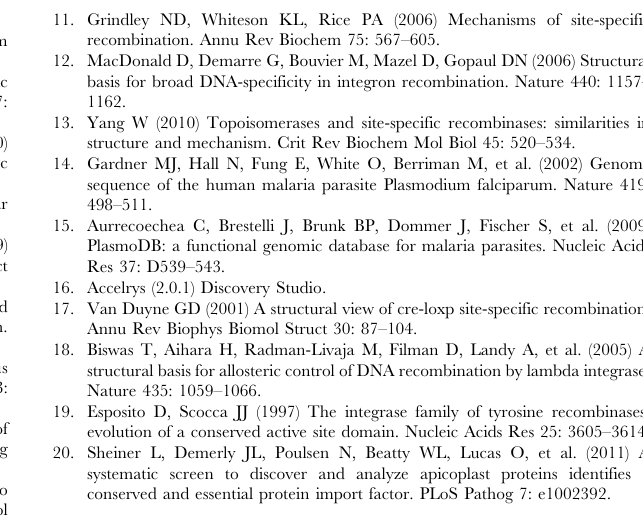
Figure S4 Analysis of DNA binding by Pf-Int. A ) Supershift assay confirms the presence of Pf-Int bound to the DNA. The binding of His 6 -Pf-Int-C192 to Selex8 DNA target was examined by supershift using either an antibody raised against the purified recombinant Pf-Int or a commercial anti-His 5 in combination with a His-tagged version of Pf-Int-C192 protein. 10 nM of Selex8 were mixed with 0.04 m M or 0.2 m M purified His 6 -Pf-Int-C192 (lanes 3, 5, 7 and 10) and (lanes 4, 6, 8 and 11) respectively. The DNA was pre-incubated with the corresponding amount of Pf-Int for 20 minutes at room temperature before adding the antibodies for an additional 20 minutes (lanes 5, 6, 10 and 11). For lanes 7 and 8, the purified Pf-Int was pre-incubated with the anti-Pf-Int for 20 minutes before addition of the DNA target. Addition of the Pf-Int antibody disrupts the formation of the DNA-Pf-Int complex (see lanes 5–8 in comparison with lanes 3–4: disappearance of shifted band and increase of free DNA). Addition of a commercial anti-His 5 antibody resulted in the disappearance of the protein- complex band without release of the bound DNA and a tendency to form a higher molecular weight band (see lanes 10–11 compared with lanes 3–4). B ) Purified GST-AP2 domain (lanes 1 to 4) and Pf-Int-C192 (lanes 5 to 8) were allowed to bind to 10 nM labeled Selex8 probe or AP2 probe in appropriate binding buffer. Lanes 1, 2, 5 and 6: Selex8 probe. Lanes 3, 4, 7 and 8: AP2